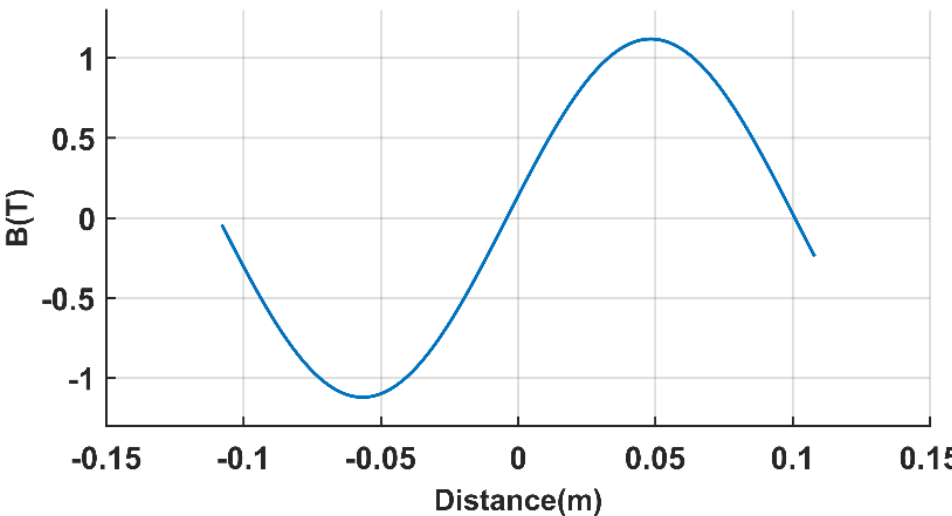
Figure 5. The slotless air-gap magnetic field within the length range of the UP-LPST.